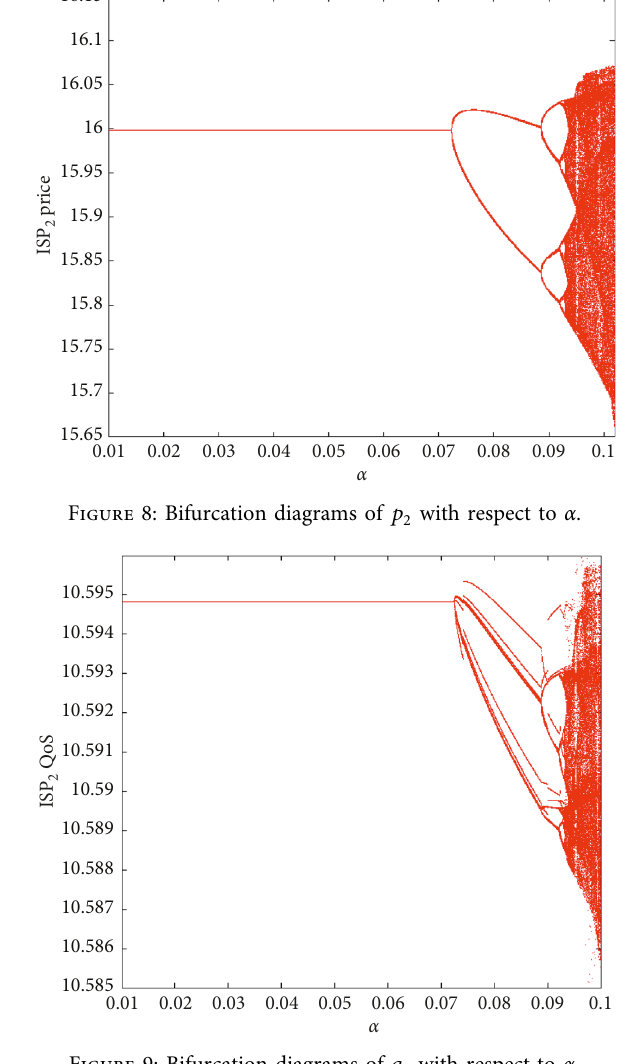
with respect to α . 2